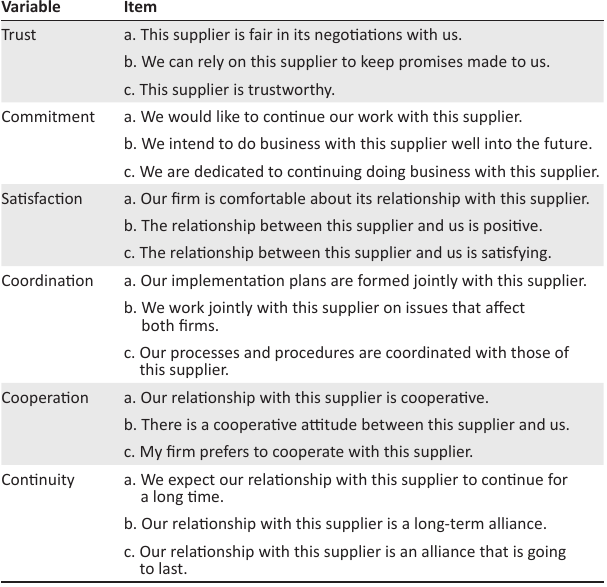
TABLE 2: Scale items: Original study and replication study . Variable